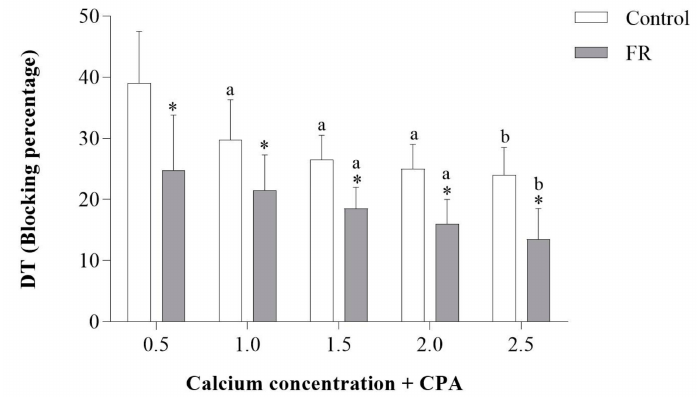
Figure 2. Blocking percentage under cyclopiazonic acid in papillary muscle preparation. C: control; FR: food restriction; CPA: cyclopiazonic acid; DT: developed tension. Data are expressed as mean ± standard deviation. Repeated measures two-way ANOVA complemented with Bonferroni post-hoc test. p < 0.05. a vs. 0.5 mM Ca 2 + concentration; b vs. 0.5 and 1.0 mM Ca 2 + concentration; * vs. control. ( n = 13–14 each